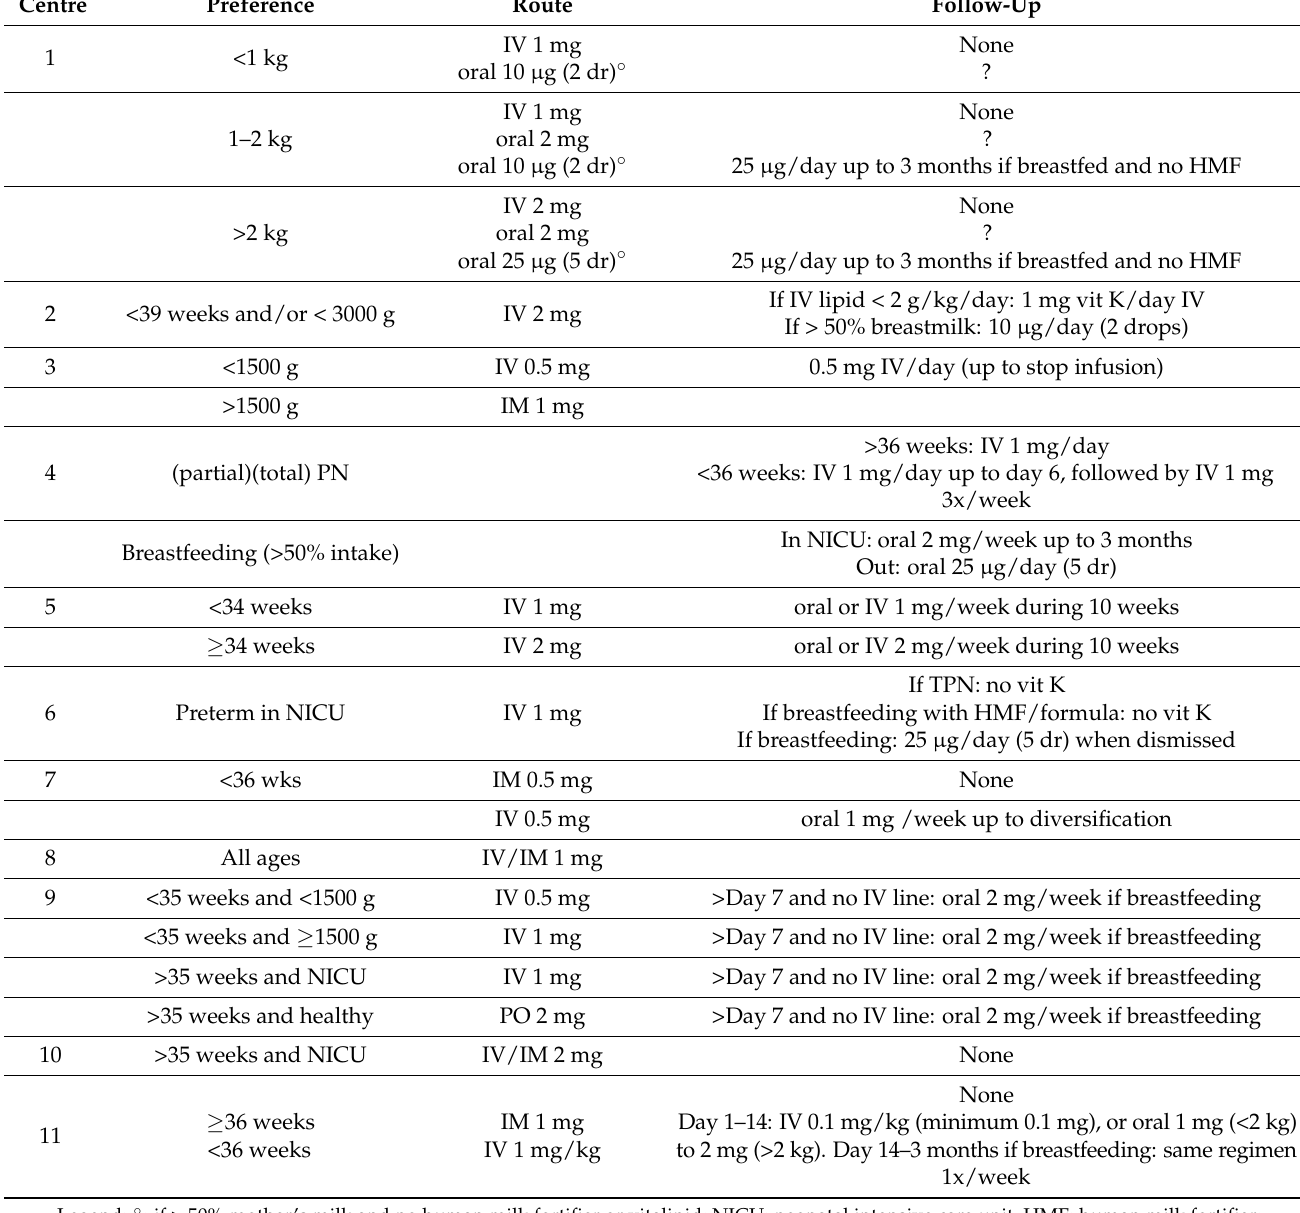
Table 5. Vitamin K administration immediately at birth in NICUs in Belgium (preterm and sick term). Centre Preference Route